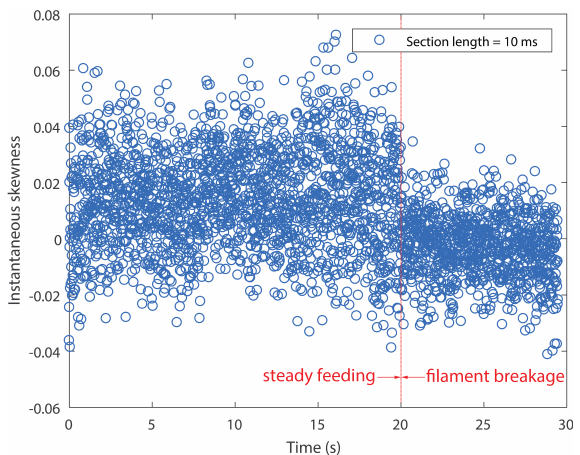
Figure 12. Instantaneous skewness of AE signal for Test #1 (section length = 10 ms).